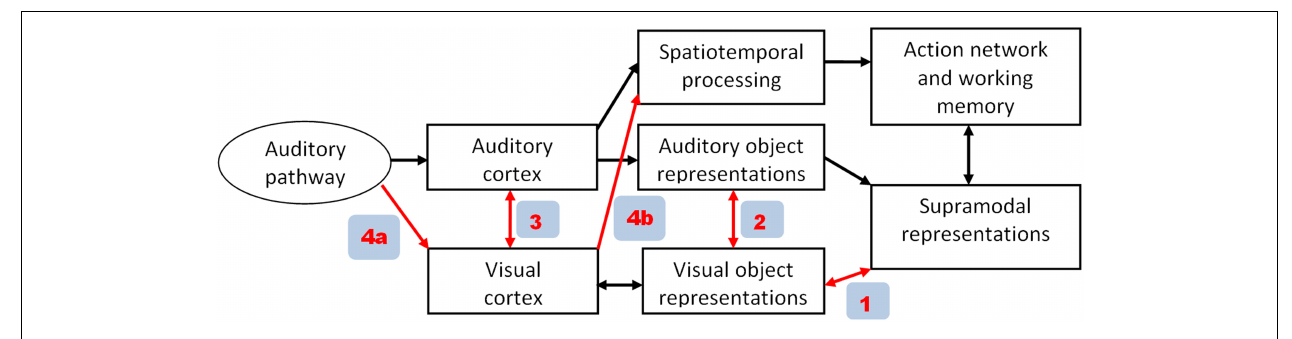
FIGURE 1 |Alternative pathways of visual cortex recruitment during auditory tasks in blind subjects. In the model proposed in the present paper (see Figure 2 ), path 4a/4b plays a major role, enabling visual cortex to process event-timing based on afferent auditory